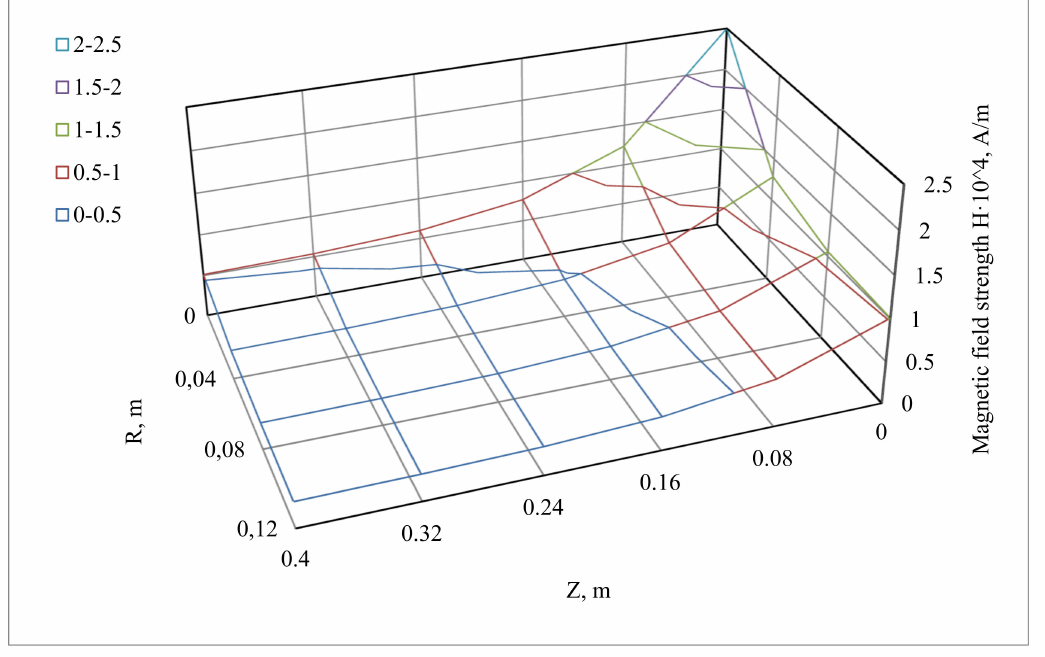
Figure 7. The change in the magnetic field strength in the working chamber of the hydrocyclone, calculated by the Formula